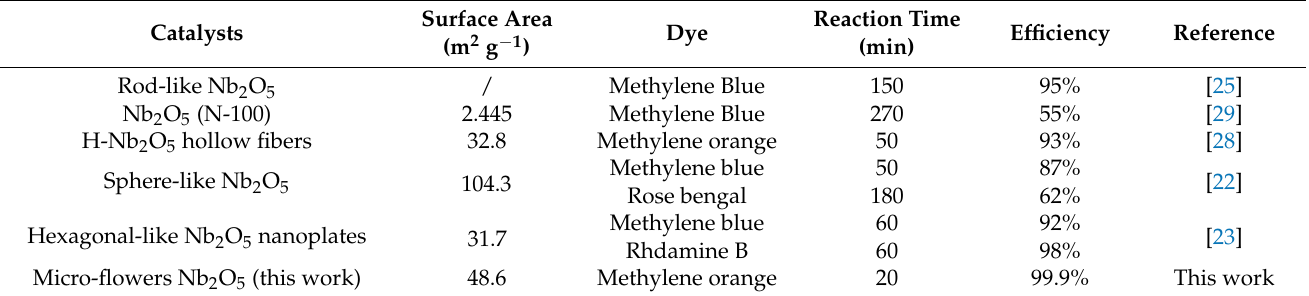
Figure 5. ( a ) Curves of MO dye photooxidation catalyzed by the as-prepared samples under UV irradiation; ( b ) pseudo first-order reaction kinetics of the as-prepared samples for degradation of MO; ( c ) Cycling performance of photocatalytic degradation of MO over Nb 2 O 5 micro-flowers; ( d ) Photocatalytic degradation mechanism of MO on mesoporous Nb 2 O 5 micro-flowers. Table 1. A comparison of the photocatalytic